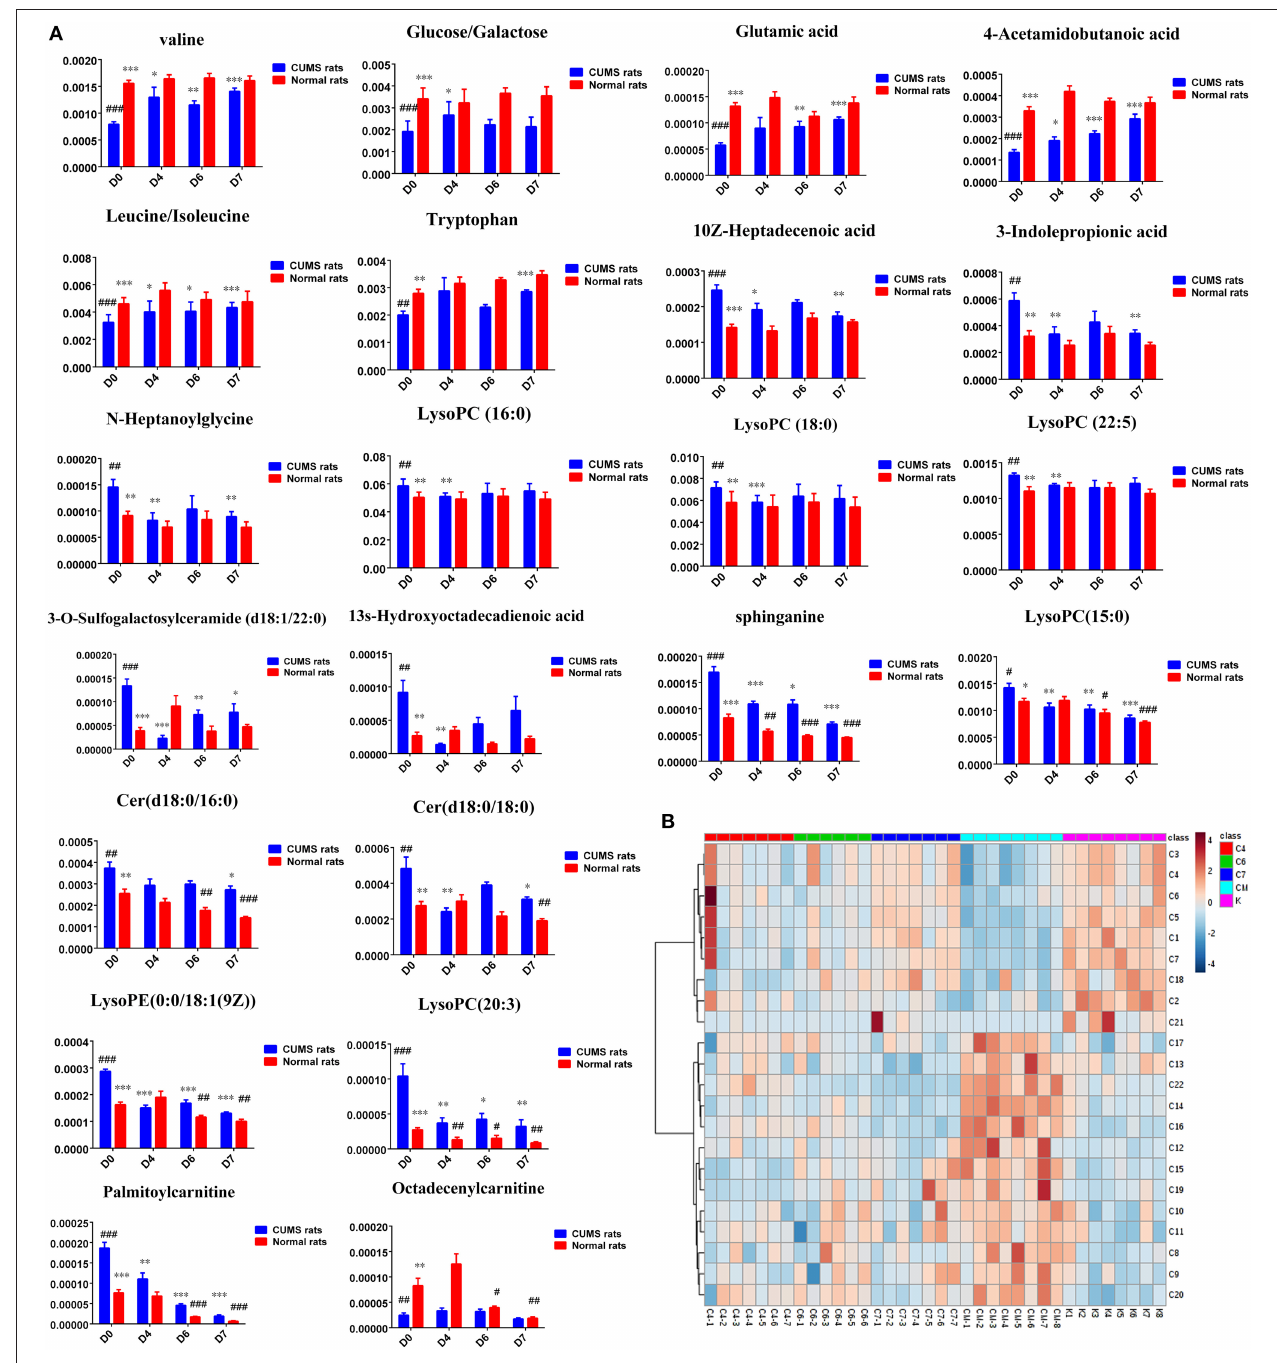
FIGURE 3 | (A) Normalized intensity levels of differential metabolites in serum samples of CUMS rats ( blue), and the relative content of the corresponding metabolites in normal rats ( red). D0: administration of an equal volume of vehicle. D4: the concentration of PBR was 1.25g/ml (expressed as the weight of raw materials). D6: the concentration of PBR was 5.0g/ml. D7: the concentration of PBR was 10.0g/ml. Data are presented as mean ± SEM. n = 8 each group. * P < 0.05, ** P < 0.01, *** P < 0.001 vs. [CM] group; # P < 0.05, ## P < 0.01, ### P < 0.001 vs. [K] group; (B) the relative content of the heatmap of differential metabolites in serum samples of CUMS rats with PBR treatment. Class C4: the [C4] group. Class C6: the [C6] group. Class C7: the [C7] group. Class CM: the [CM] group. Class K: the [K] group. The ribbon − 4 ∼ 4: represents the relative content of the differential metabolites from low to high.